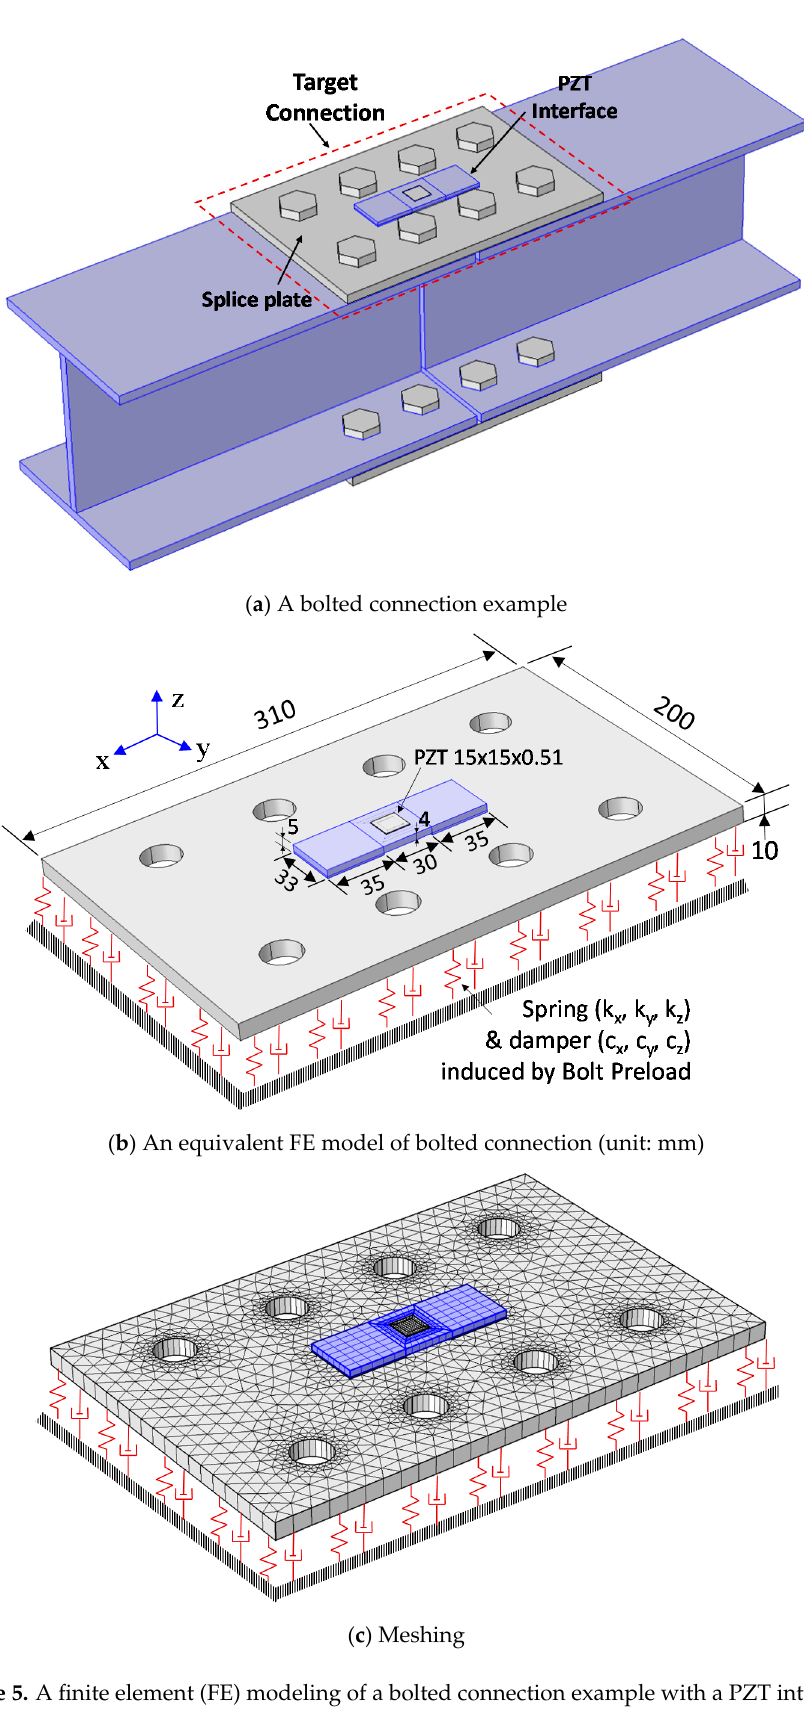
Figure 5. A finite element (FE) modeling of a bolted connection example with a PZT interface.